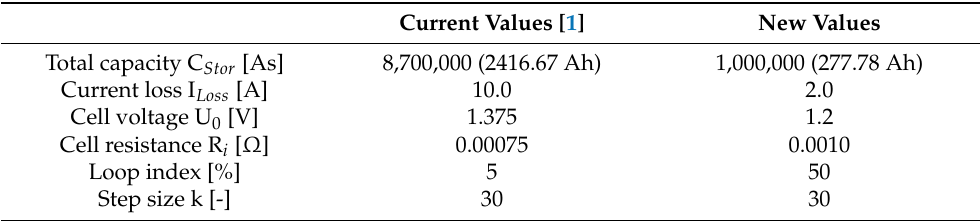
Table 4. Comparison of the preset parameters of the simulation